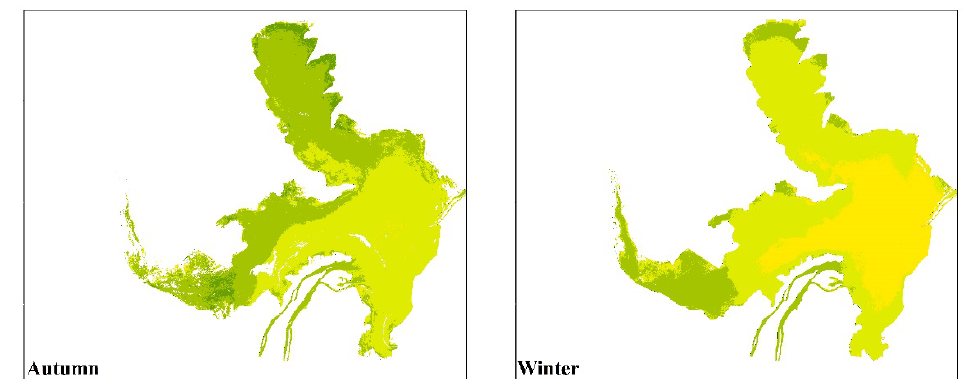
Figure 8. Seasonal changes in the TSM concentration in the Hongze Lake.